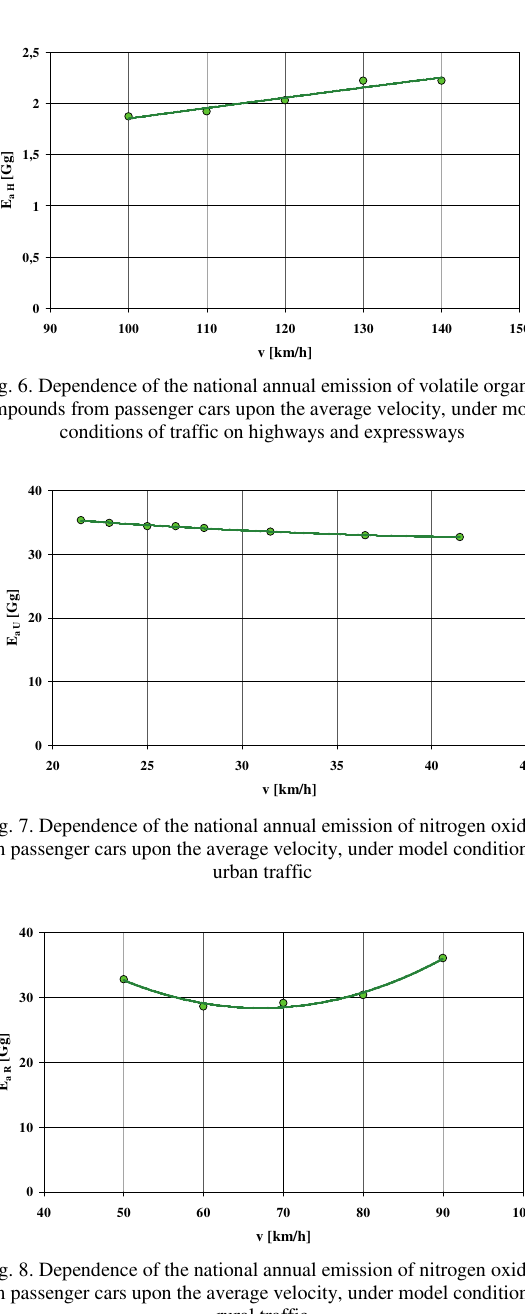
Fig. 5. Dependence of the national annual emission of volatile organic Fig. 9. Dependence of the national annual emission of nitrogen oxides compounds from passenger cars upon the average velocity, under model from passenger cars upon the average velocity, under model conditions of conditions of rural traffic traffic on highways and expressways